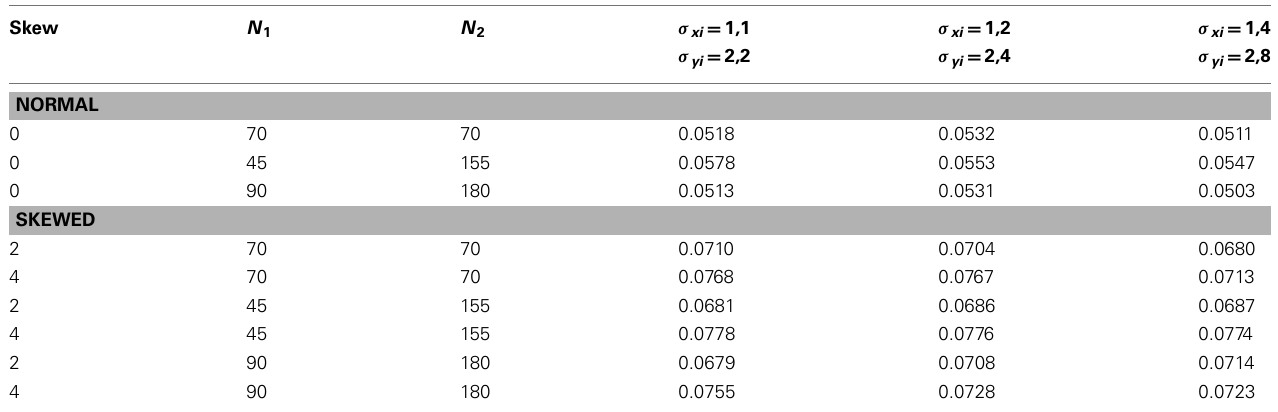
Table 1 |Type I error: two-groups